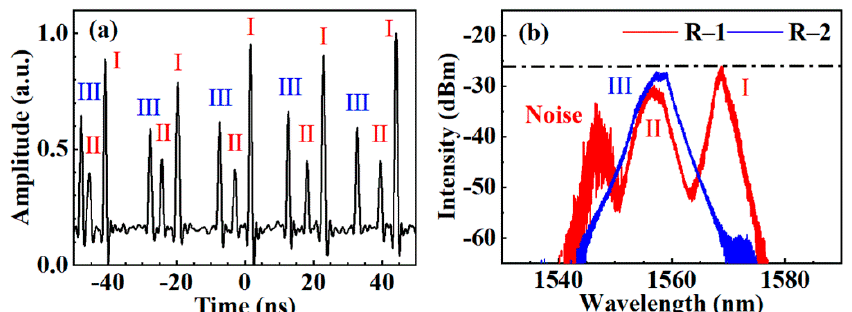
Figure 2. The pulse train and spectral characteristics of the generated tri-comb with dual-comb and single-comb output from sub-ring 1 and sub-ring 2, respectively. ( a ) Pulse trains, ( b ) optical spectrum. I and II stand for the pulse trains from sub-ring 1, whereas III stands for the pulse train from sub-ring 2. R-1, sub-ring 1. R-2, sub-ring 2.